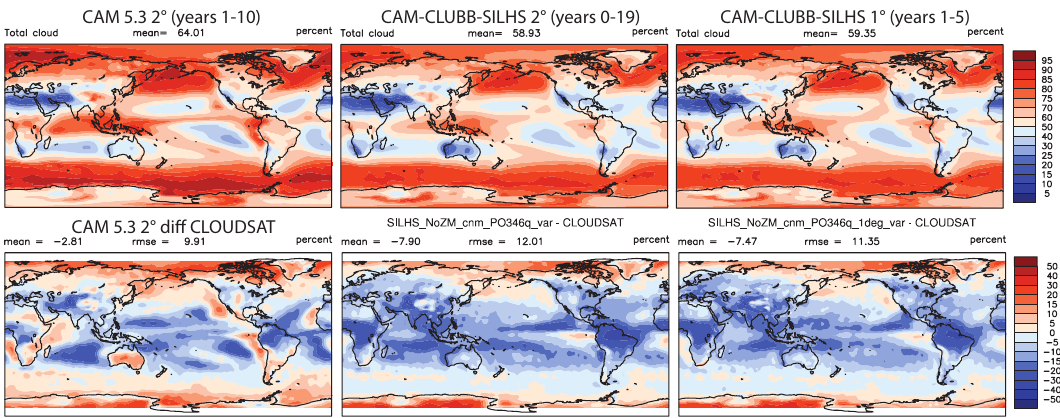
Figure 6. Total grid-box cloud fraction for CAM 5.3 (left), CAM-CLUBB–SILHS 2 ◦ (center), and CAM-CLUBB–SILHS 1 ◦ (right). The difference from CLOUDSAT observations of total cloud fraction is shown in the second row. The global mean cloud fraction in CAM- CLUBB–SILHS is reduced by about 5% compared to the CAM 5.3 mean